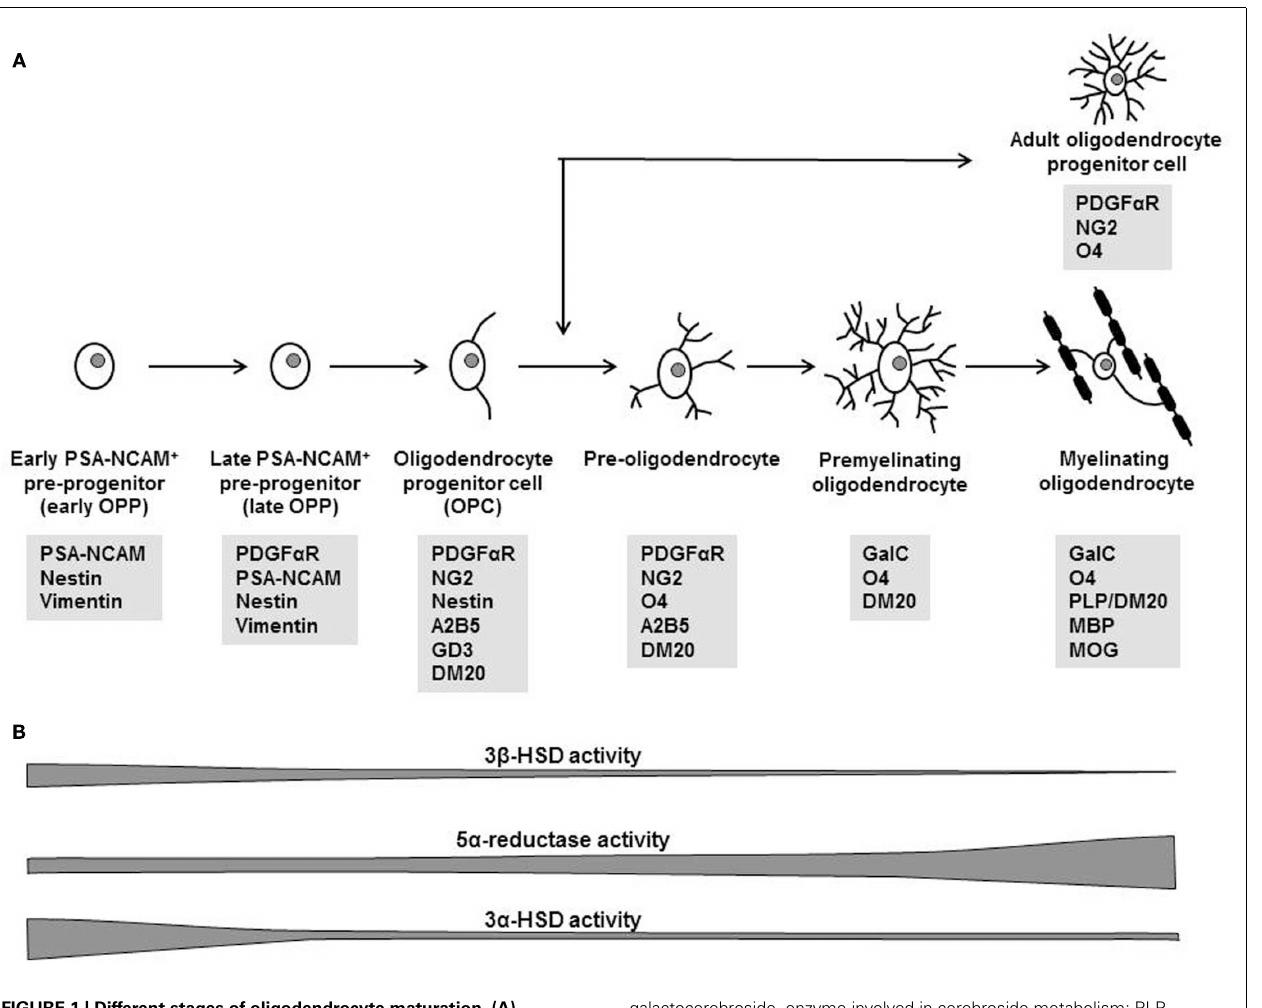
galactocerebroside, enzyme involved in cerebroside metabolism; PLP, proteolipid protein, MBP, myelin basic protein; MOG, myelin oligodendrocyte protein). (Adapted from Levine et al., 2001; Gago et al., 2003 and Ghoumari et al., 2005). (B) Schematic presentation of progesterone synthesis (3 β -HSD activity) and metabolism (5 α -reductase and 3 α -HSD activities) by oligodendroglial cells at different stages of their maturation (adapted from Gago et al.,